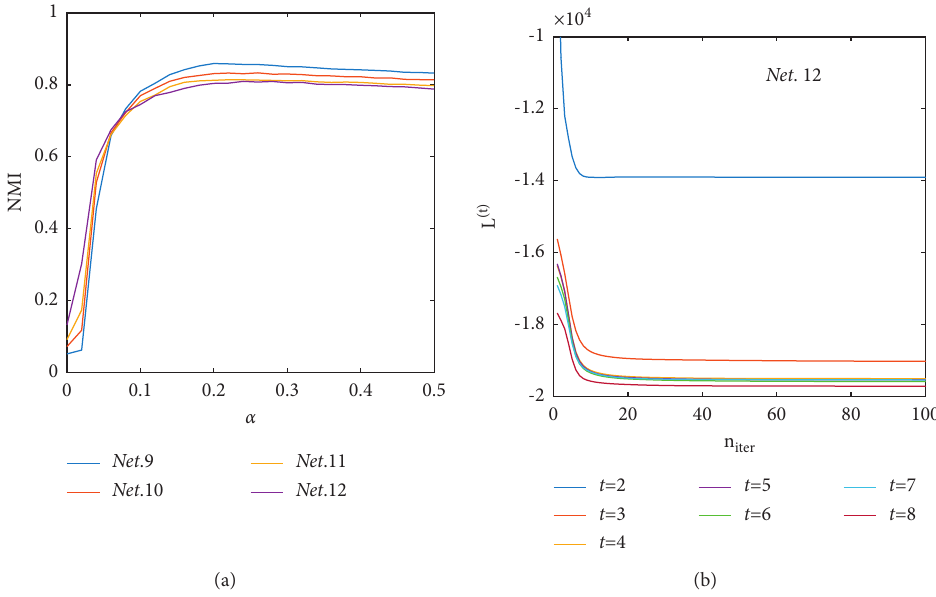
Figure 7: (a) Parameter analysis of the balance parameter α on Net. 9 − 12; (b) the convergence analysis of L ( t ) on Net.